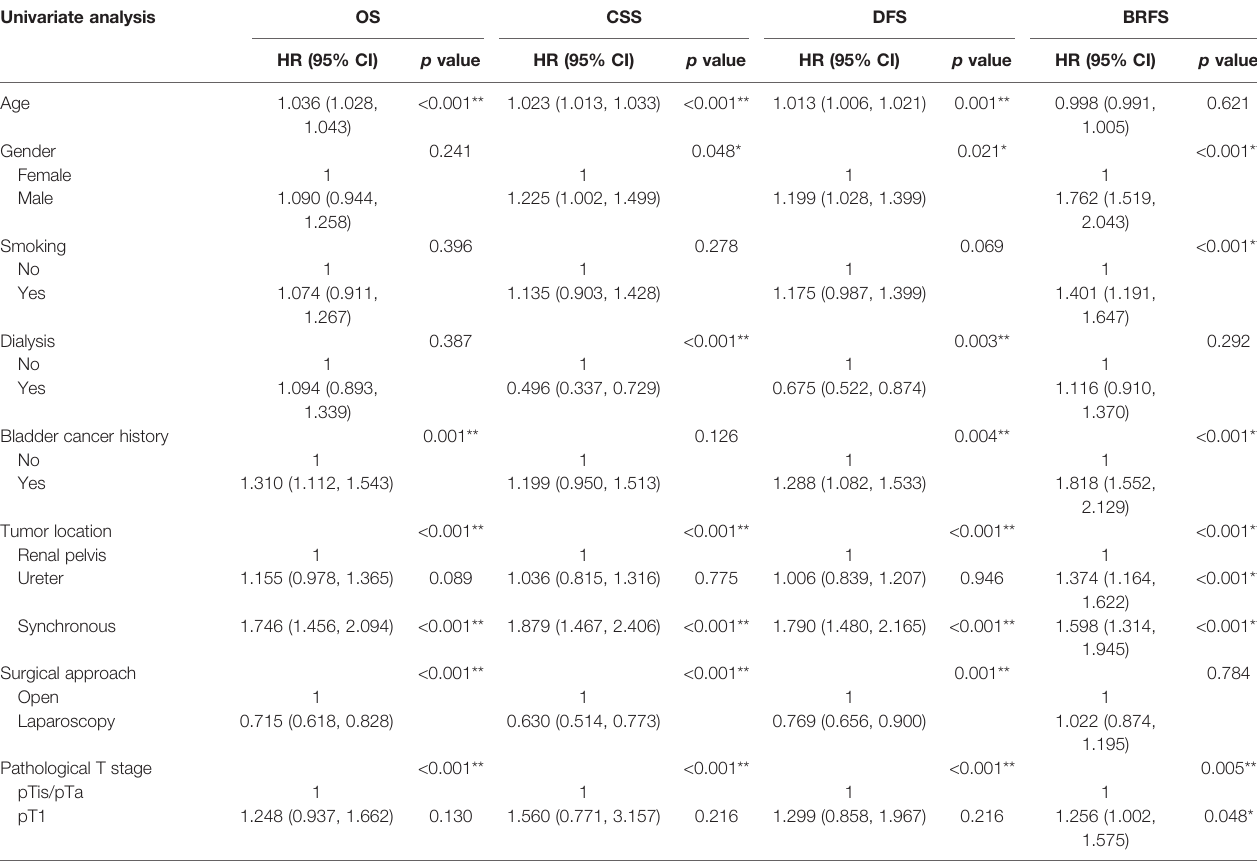
TABLE 3 | Comparative univariate survival analysis of UTUC